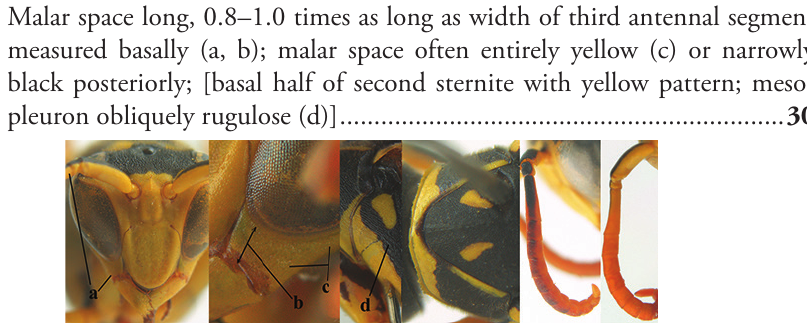
– Malar space short, 0.4–0.6 times basal width of third antennal segment (aa, bb); malar space black posteriorly with black area often widened (cc) ....... 31